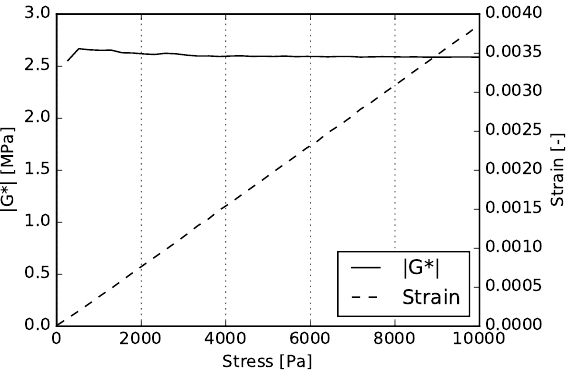
Figure 11. PVB linearity test at 60 ◦ C for the dynamic torsion